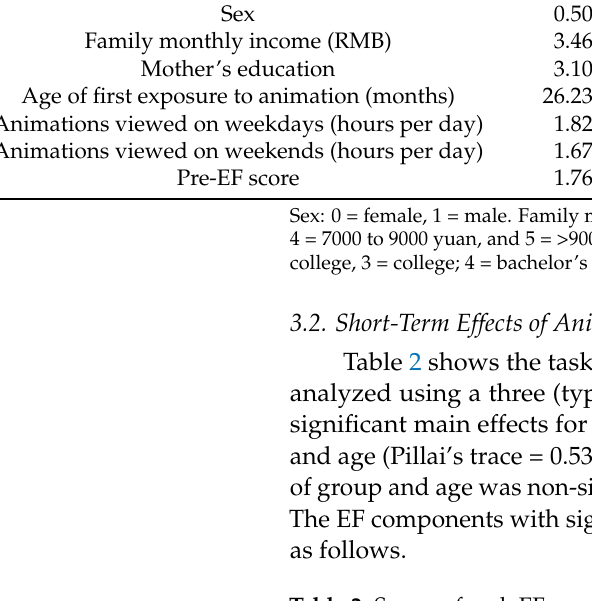
Table 2. Scores of each EF component for different